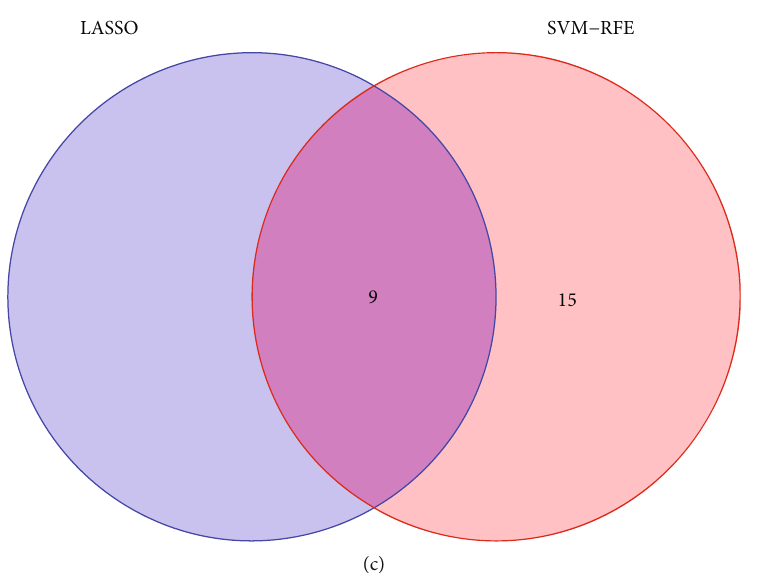
Figure 4: Selection of potential renal fi brosis diagnostic biomarkers. (a) Tuning feature selection in the LASSO. (b) The SVM-RFE technique was used to pick biomarkers. (c) In this Venn diagram, the SVM-RFE and LASSO algorithms are shown to have four diagnostic markers between